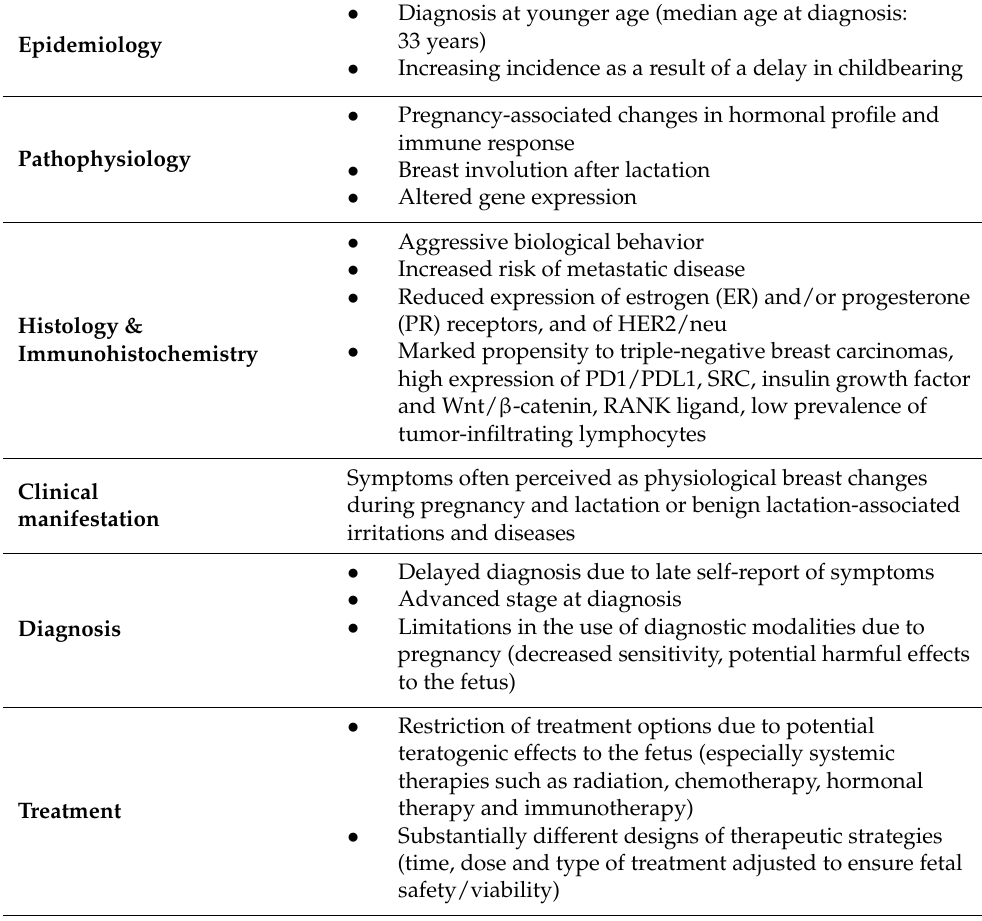
Table 1. Specific characteristics of PABC—differences from non-pregnancy-associated breast